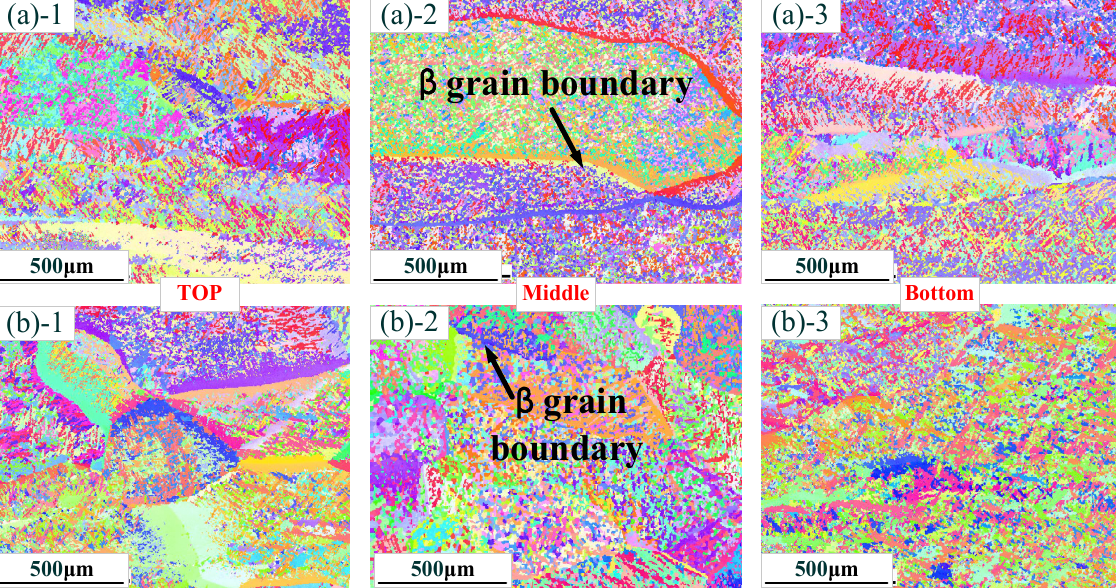
Figure 3. Distribution of grain morphology in different zones: ( a ) without La 2 O 3 ; ( b ) with La 2 O 3 . (Note: (a)-1 and (b)-1 show the top zone, (a)-2 and (b)-2 show the middle zone, and (a)-3 and (b)-3 show the Bottom zone)